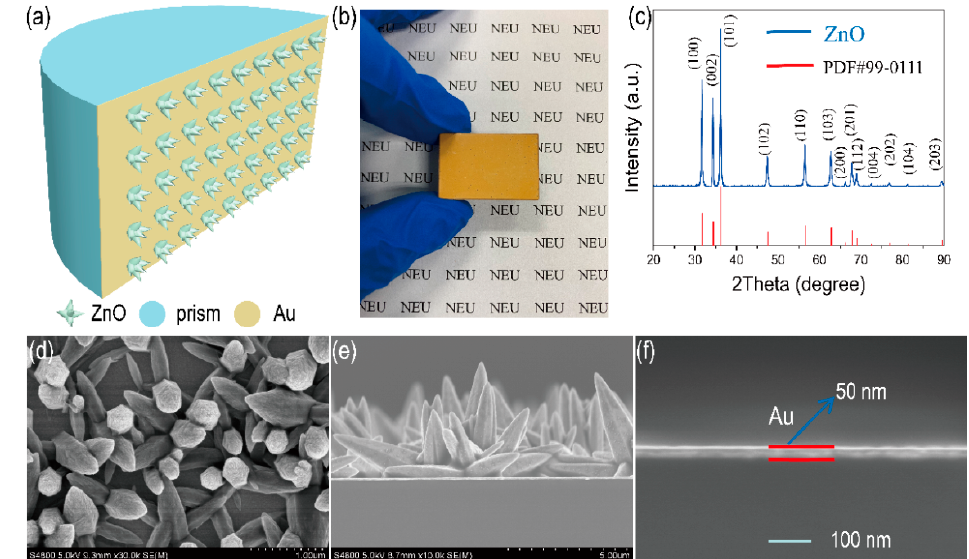
Figure 2. Schematic diagram of morphological characterization. ( a ) ZnO nanoflowers/Au structure. ( b ) Optical graph of the device. ( c ) XRD pattern of ZnO nanoflowers. ( d ) Top-view SEM image of ZnO nanoflowers/Au structure. ( e ) Side-view SEM image of ZnO nanoflowers/Au structure. ( f ) Side-view SEM image of Au film.